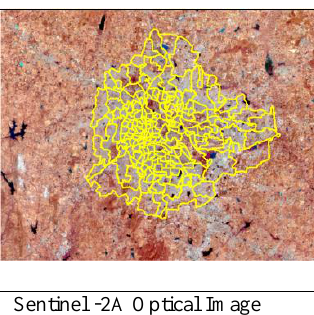
Sentinel -2A Optical Image Figure 3: Satellite Image and GIS generated ward boundary